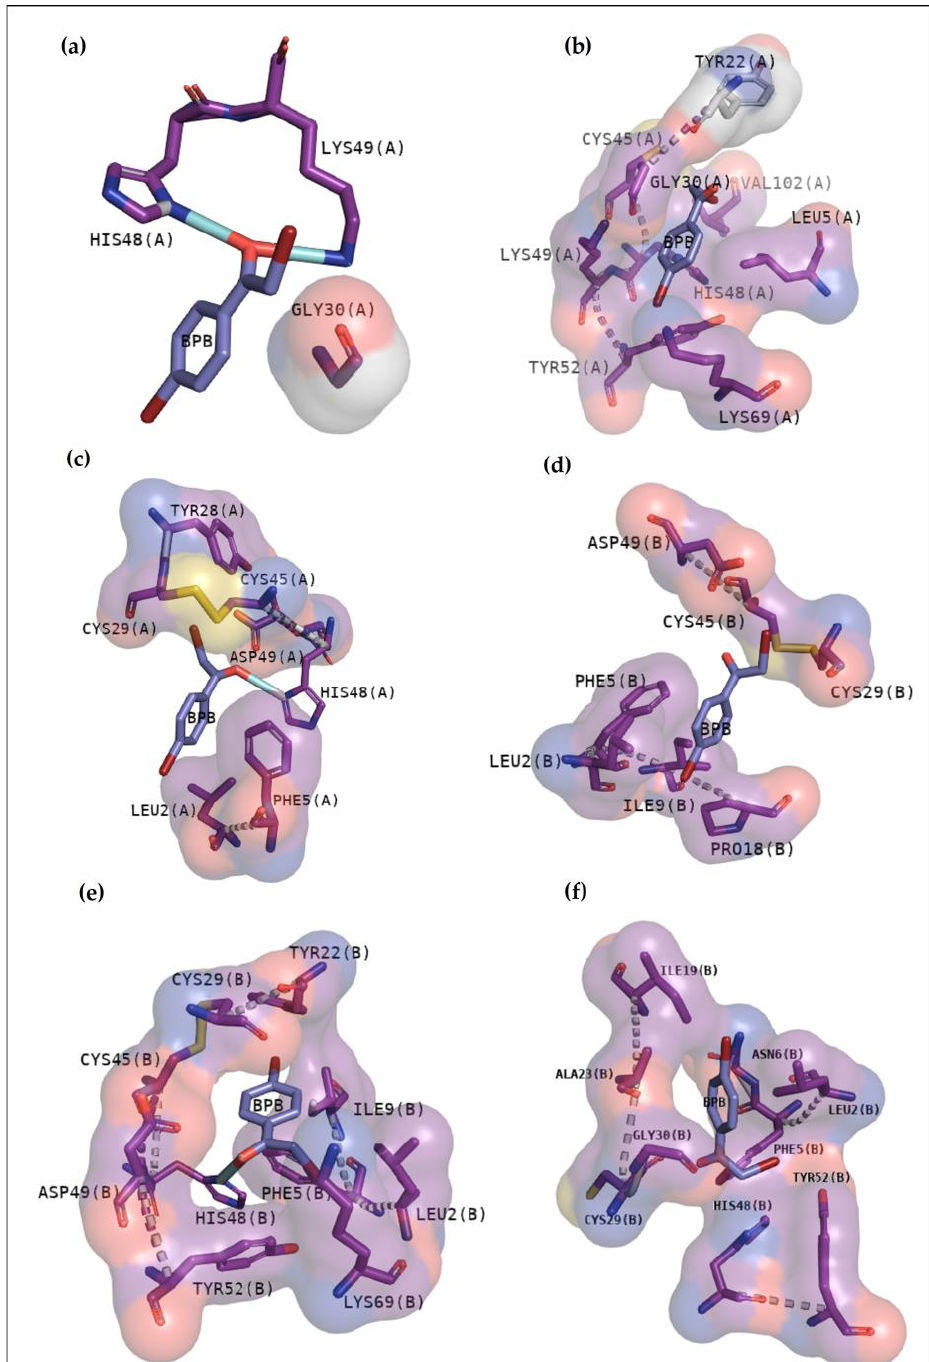
Figure 4. BPB docking results with BthTX-I, BthTX-II and CdtsPLA2. BthTX-I exhibits in the first cluster hydrogen bonds with His48 and Lys49, besides to exhibit hydrophobic contacts with Gly30 ( a ), while second cluster shows hydrophobic contacts with N-terminal residues, Gly30, His48, Lys49, Tyr52 and Lys69 ( b ). Hydrogen bond with His48 is also observed in BthTX-II in the first cluster, besides to show hydrophobic contacts with N-terminal region ( c ), and hydrophobic contacts in the second cluster ( d ). Similarly, BPB with CdtsPLA2 reveal hydrogen bond with His 48 and hydrophobic contacts with essential amino acids ( e ), and ( f ) exhibits just hydrophobic contacts. Purple and red colors around residues represent hydrophobic contacts with the compound, Table 2. Binding free energy (affinity) and rmsd values of each toxin with BPB. 1º Cluster 2º Cluster Affinity Rmsd (l.b.; Affinity Rmsd (l.b.; u.b.) (kcal/mol) u.b.) (kcal/mol)